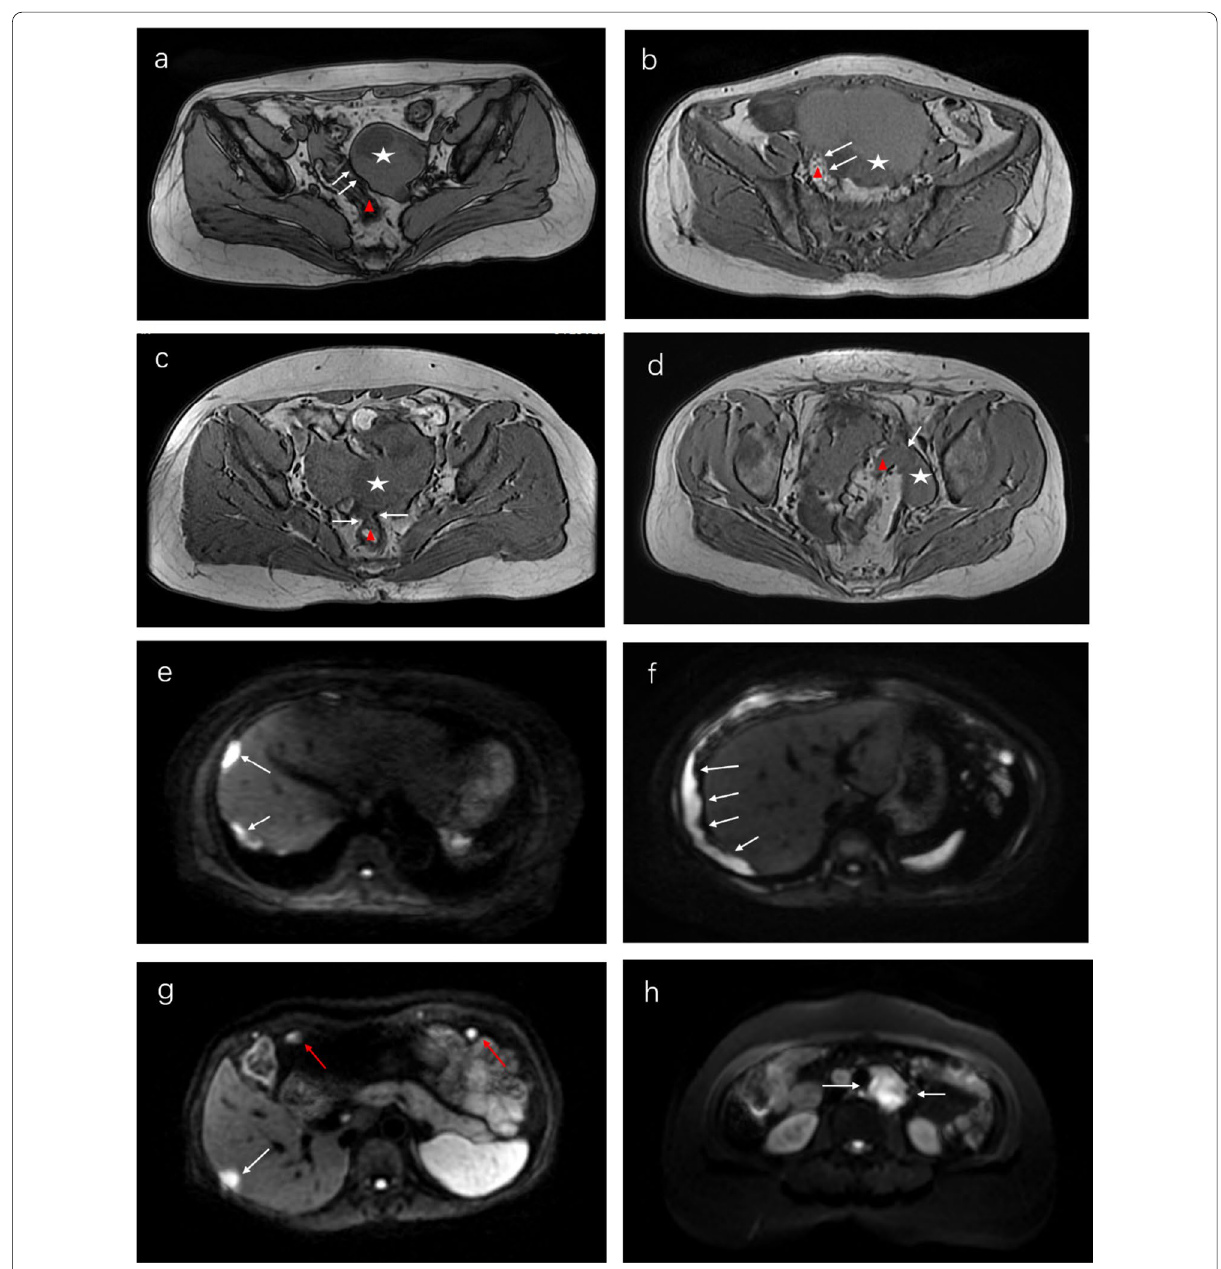
Fig. 2 Image features of the MRI variables. a – d Four grades of relationship between the sigmoid colon/rectum and ovarian mass. a Axial MR T1 dual-echo (MR-T1-DE) image shows grade 0 (clear). A hook edge sign existed (white arrowheads) between the sigmoid colon (red triangle) and ovarian mass (white star). b Axial MR-T1-DE image shows grade 1 (close). The hook edge disappeared, but the shape of the sigmoid colon (red triangle) and ovarian mass (white star) can be vaguely distinguished (white arrowheads). c Axial MR-T1-DE image shows grade 2 (bridge sign). The hook edge disappeared, and the rectum (red triangle) and ovarian mass (white star) were limited adhered (white arrowheads). d Axial MR-T1-DE image shows grade 3 (fusion). The hook edge disappeared, and the sigmoid colon (red triangle) and ovarian mass (white star) fused into a block (white arrowheads). e , f Diaphragmatic metastasis. e Diffusion-weighted image shows hyperintense nodules implanted under the diaphragm (white arrowheads). f DW image shows extensive thickening of the diaphragm with hyperintensity (white arrowheads). g Metastases of liver and omentum. DW image shows hyperintense nodules of liver (white arrowhead) and omentum (red arrowheads). h Retroperitoneal lymphadenopathy. DW image shows significant hyperintensity of retroperitoneal enlarged lymph nodes (white